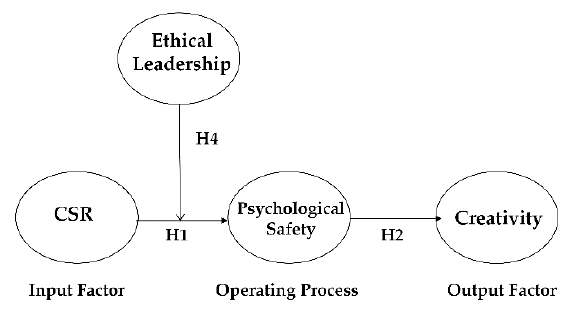
Figure 1. Theoretical model.